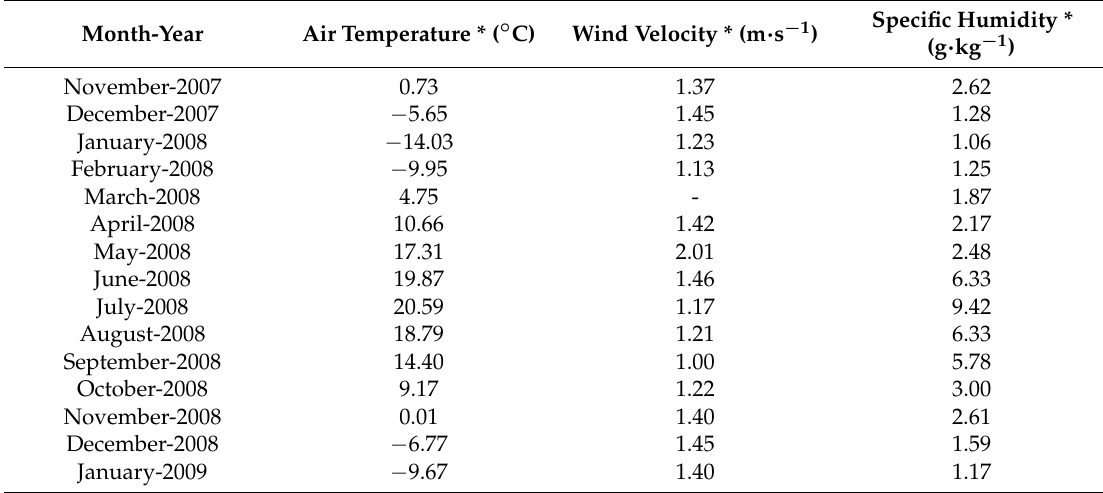
Table 3. Monthly averages of the meteorological elements observed at the Yingke site from November 2007 to January 2009.